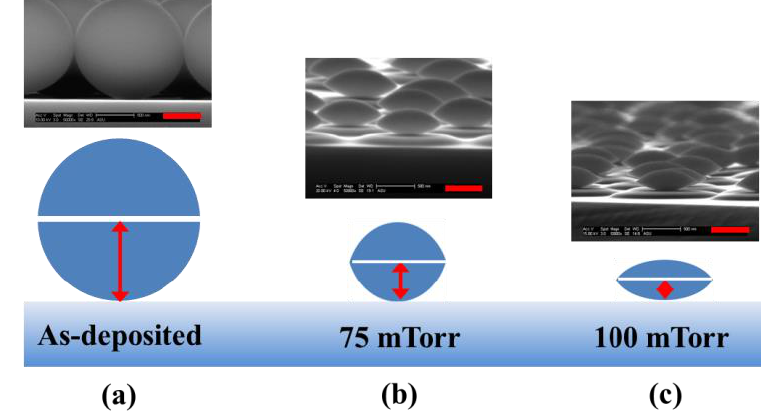
Figure 3. SEM images of SS ( a ) as-deposited, and after reactive-ion etching (RIE) process at ( b ) 75 mTorr, and ( c ) 100 mTorr.